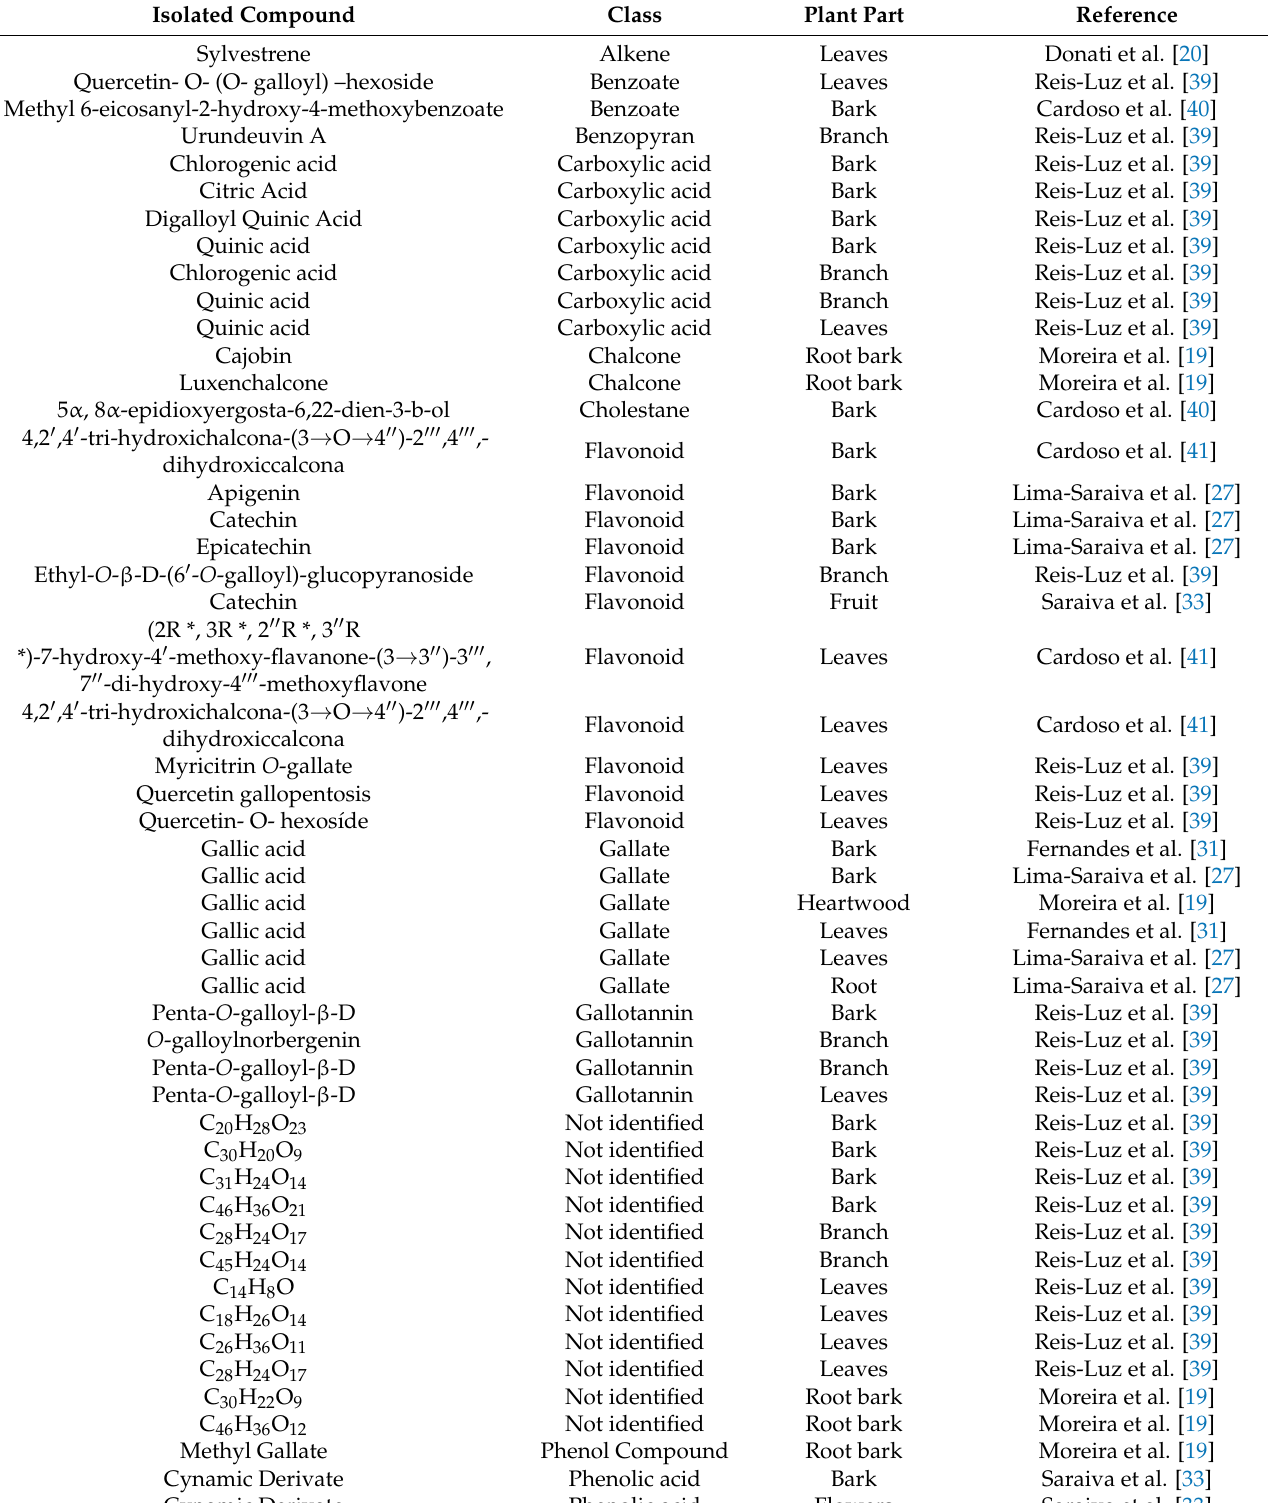
Table 3. Isolated compounds from Schinopsis brasiliensis